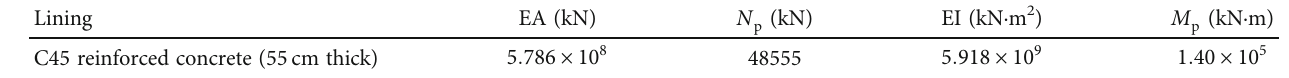
Table 1: Mechanical parameters of the lining used in numerical calculation. Lining